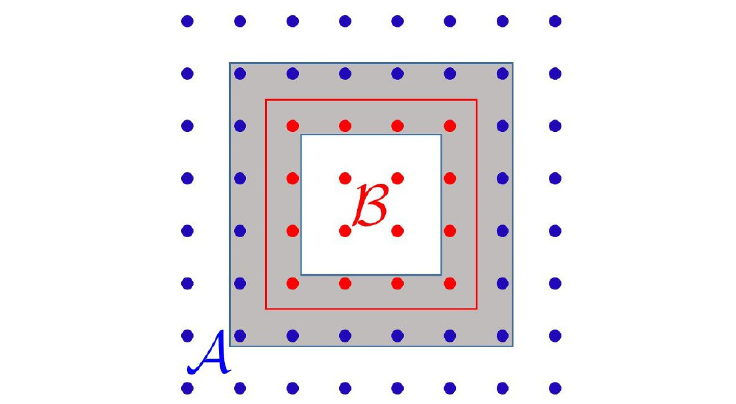
Figure 2 . A 2-D lattice divided by the red contour of length ‘ into two disjoint regions thickness of the shaded area is the correlation length channel between and . The entanglement entropy and mutual information scale with ‘ A B